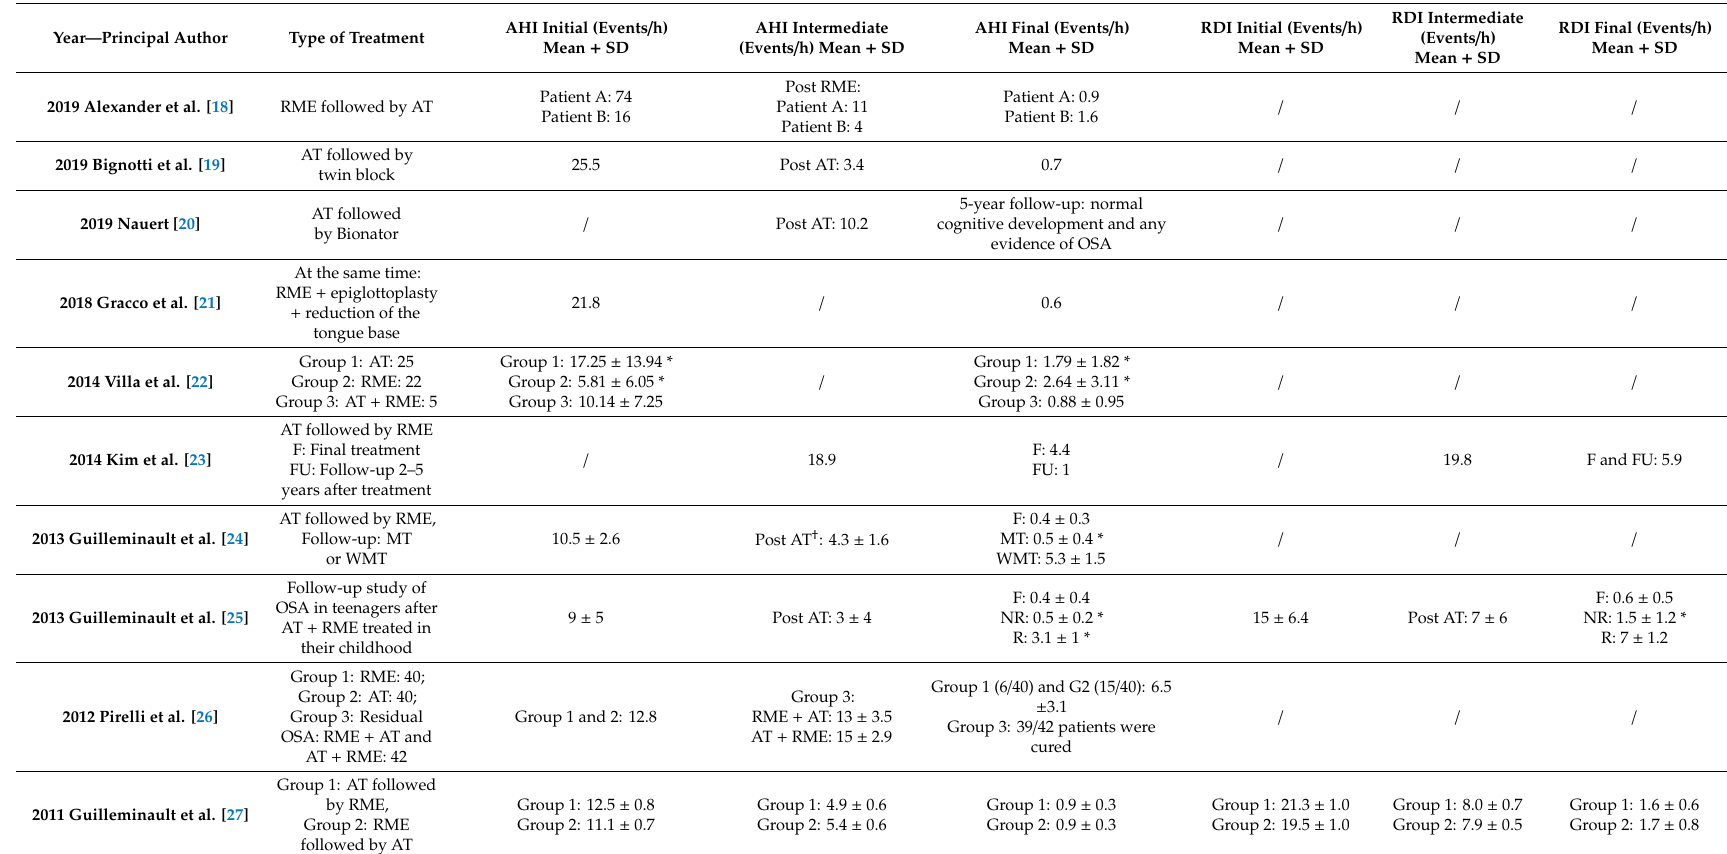
Table 2. Summary of severity of